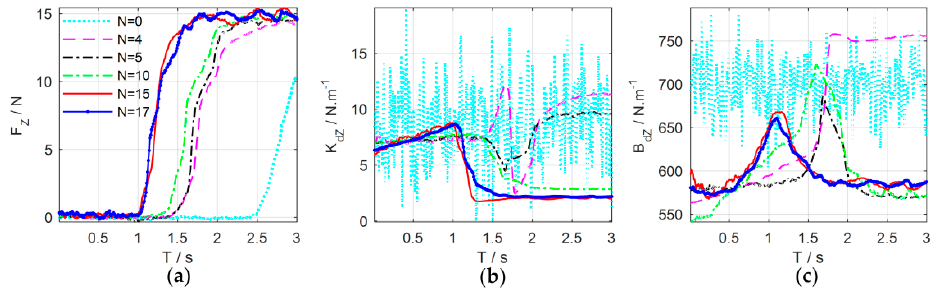
Figure 16. Main iterations of the learning process. ( a ) Contact force; ( b ) Cartesian stiffness schedules; ( c ) Cartesian damping schedules.